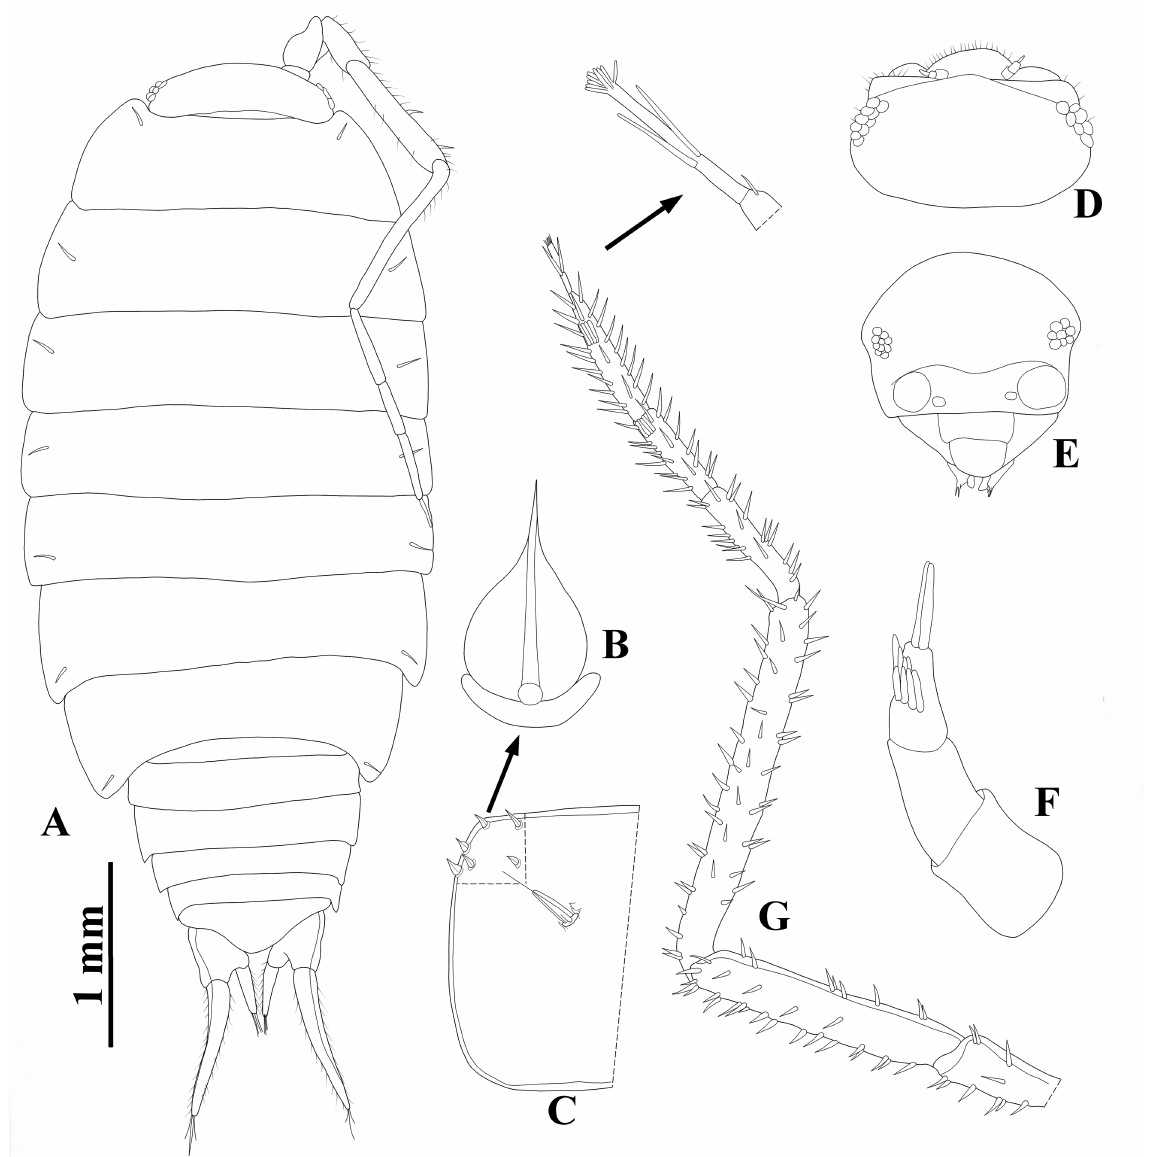
Fig. 15. Halophiloscia trichoniscoides (Vandel, 1973) comb. nov. , ♀ (MZUF 9607). A . Habitus, dorsal view. B . Dorsal scale-seta. C . Epimera 4 with noduli laterales. D . Cephalon, dorsal view. E . Cephalon, frontal view. F . Antennula. G .